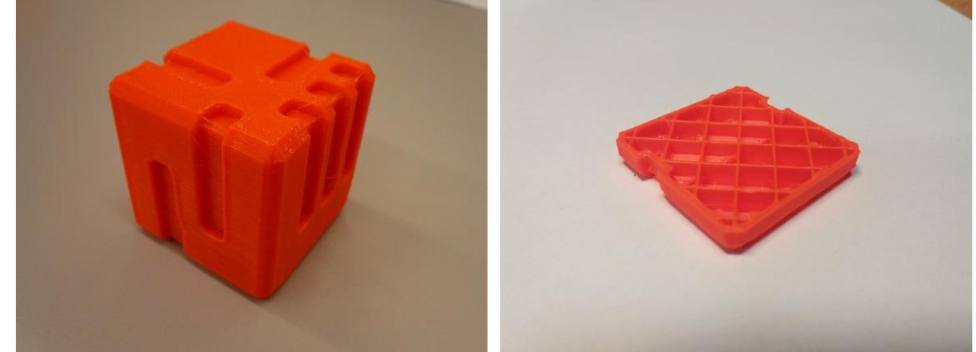
Figure 2. Printed cube and a cross-section of the printed